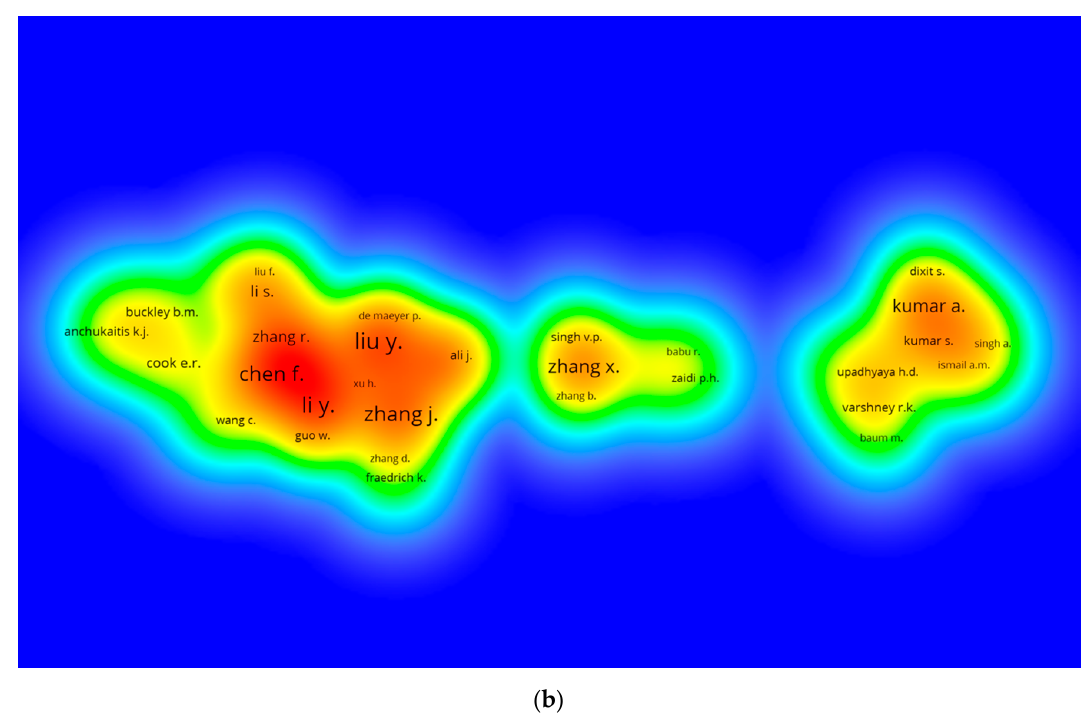
Figure 5. ( a ) . Visualization of co-authorship for drought analysis; authors with minimum five documents. Green: Li y, Red: Randerson j.t, Blue: Kumar a, Varshney r.k, Sky blue: zhang j. ( b ). Density Visualization of co-authorship for drought analysis.